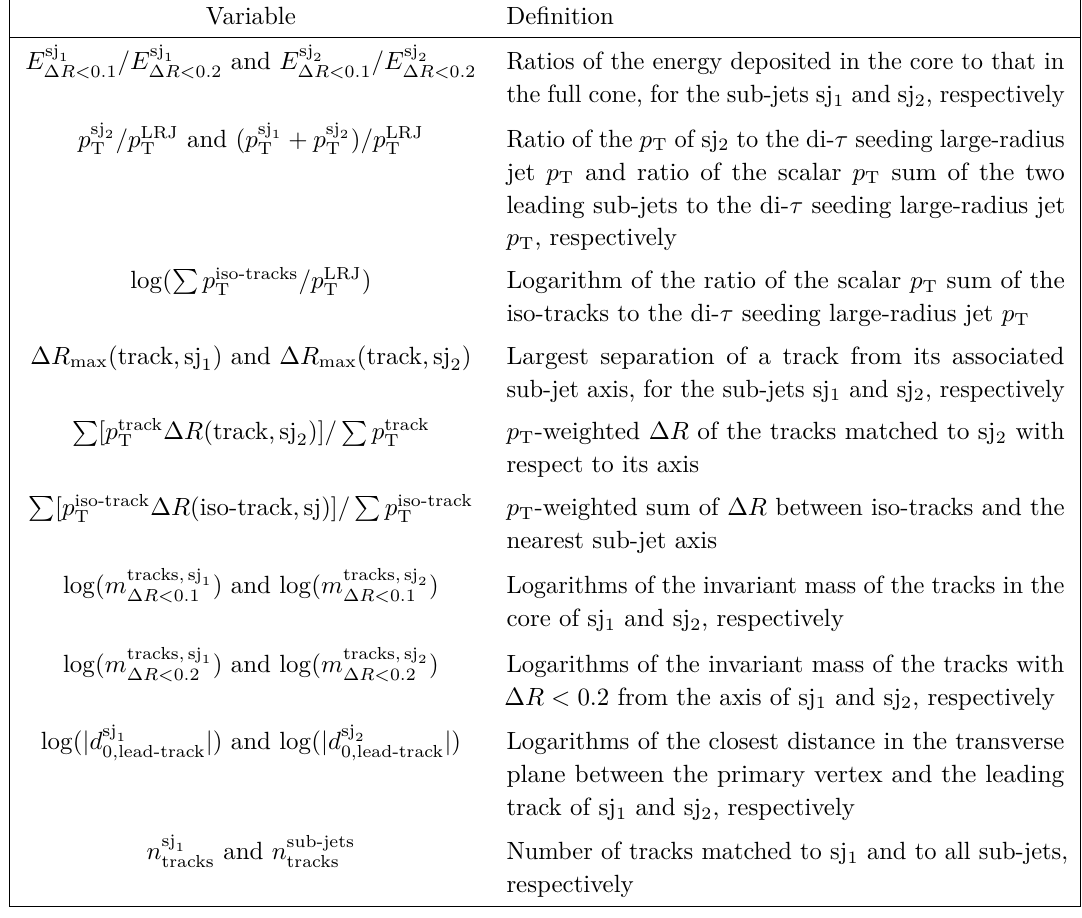
Table 1. Discriminating variables used in the di- τ identification BDT, aimed at rejecting the background from quark- and gluon-initiated jets. Here, LRJ refers to the seeding large-radius jet of the di- τ object, sj 1 and sj 2 stand for the first and second sub-jets ordered in p T , respectively, and tracks refer to those matched to a sub-jet ( τ tracks), unless specified